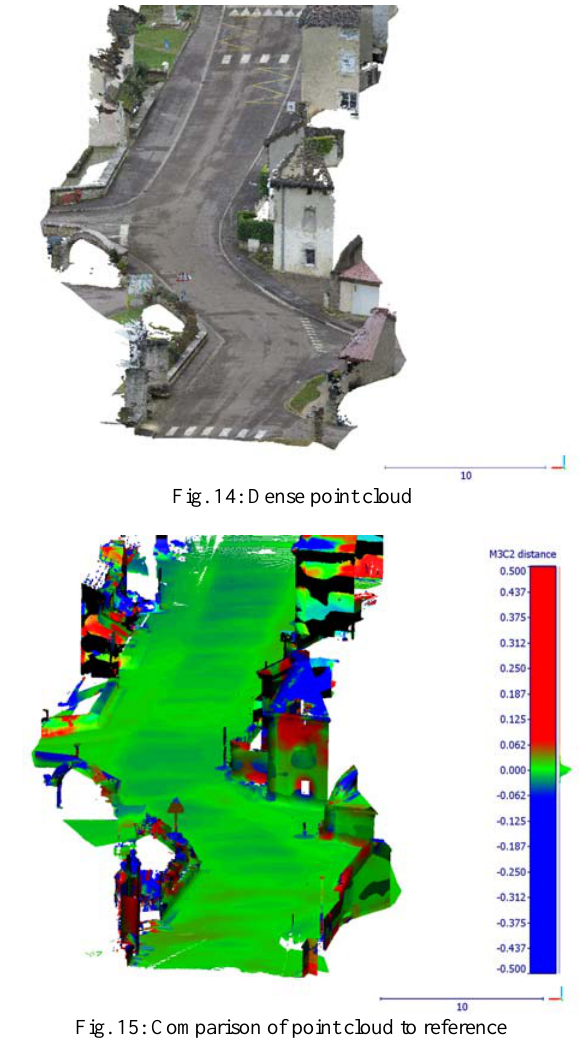
Fig. 15: Comparison of point cloud to